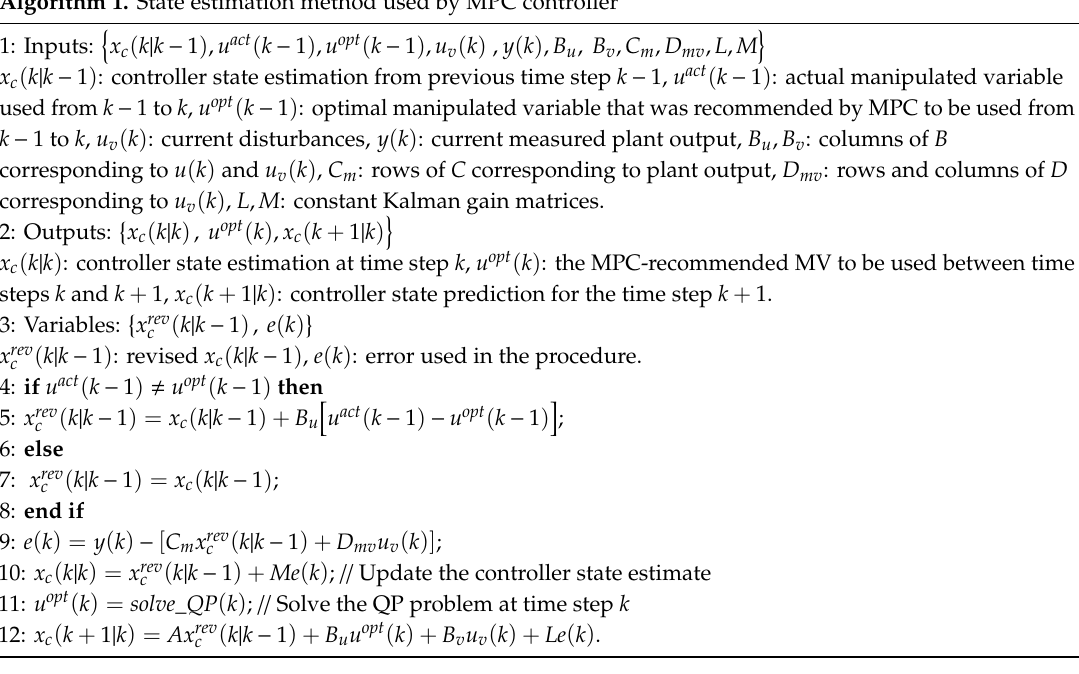
Algorithm 1. State estimation method used by MPC controller